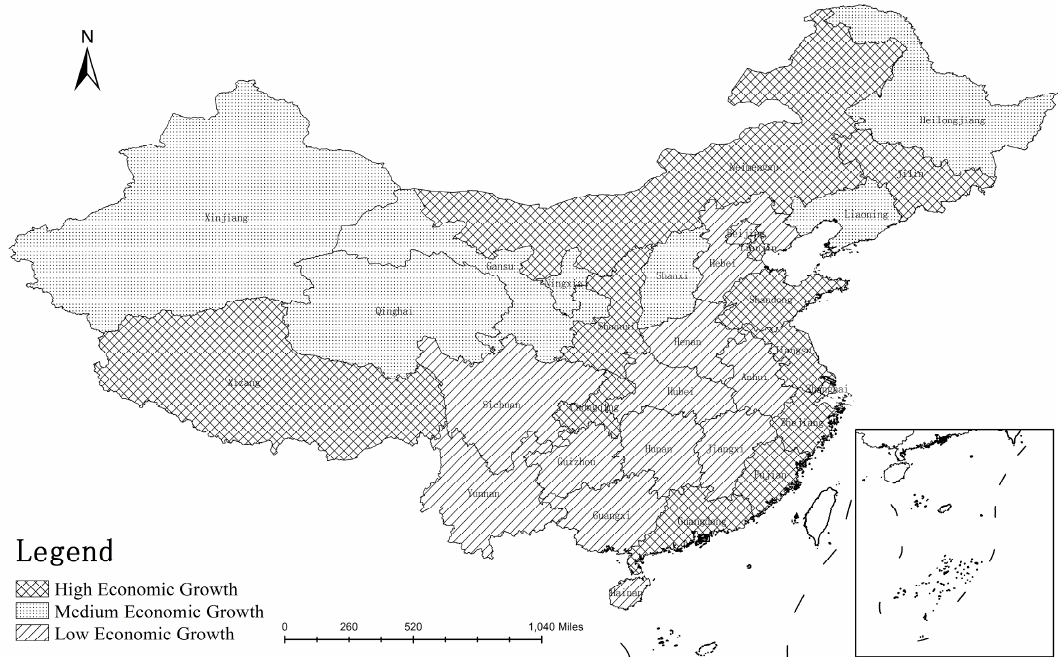
Figure 3. Economic growth mode for China’s 31 provinces.